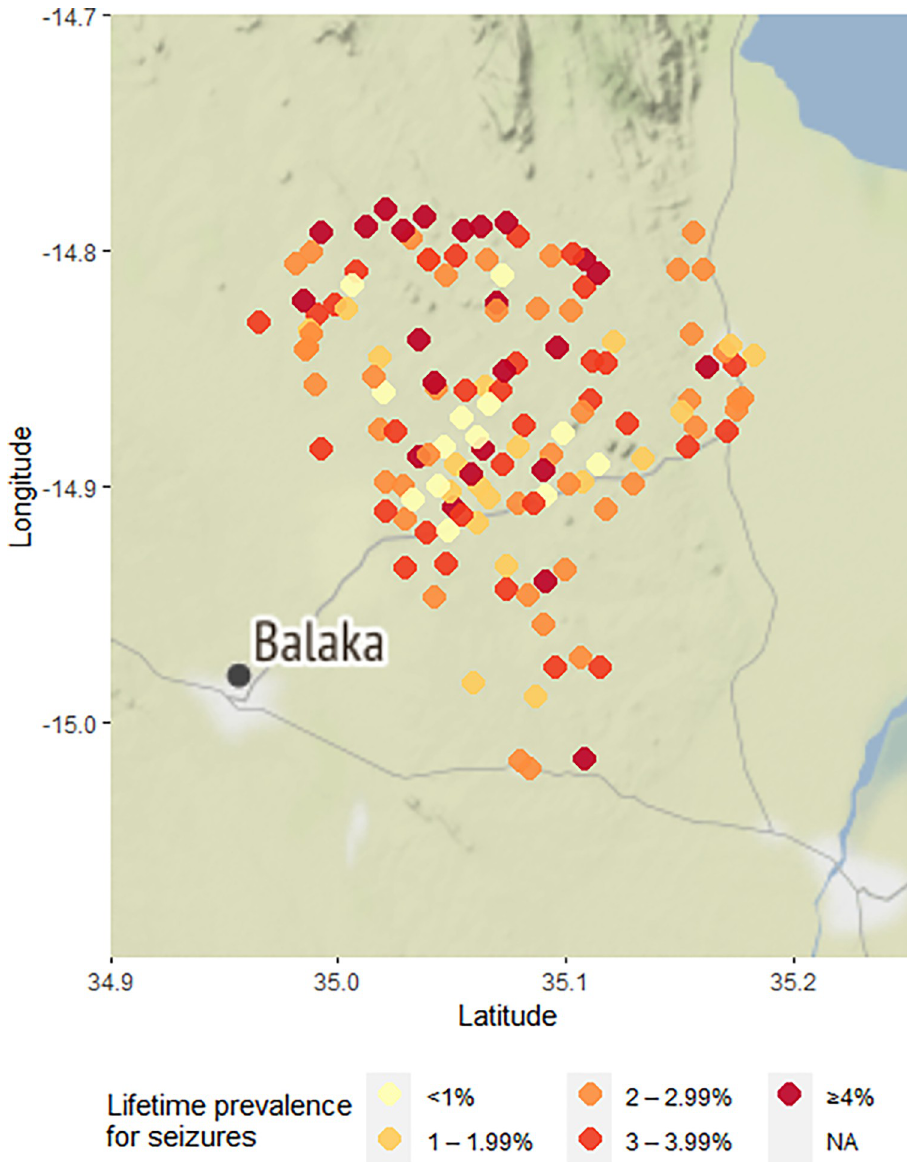
Fig 3. Villages by epileptic seizure prevalence, Balaka district,